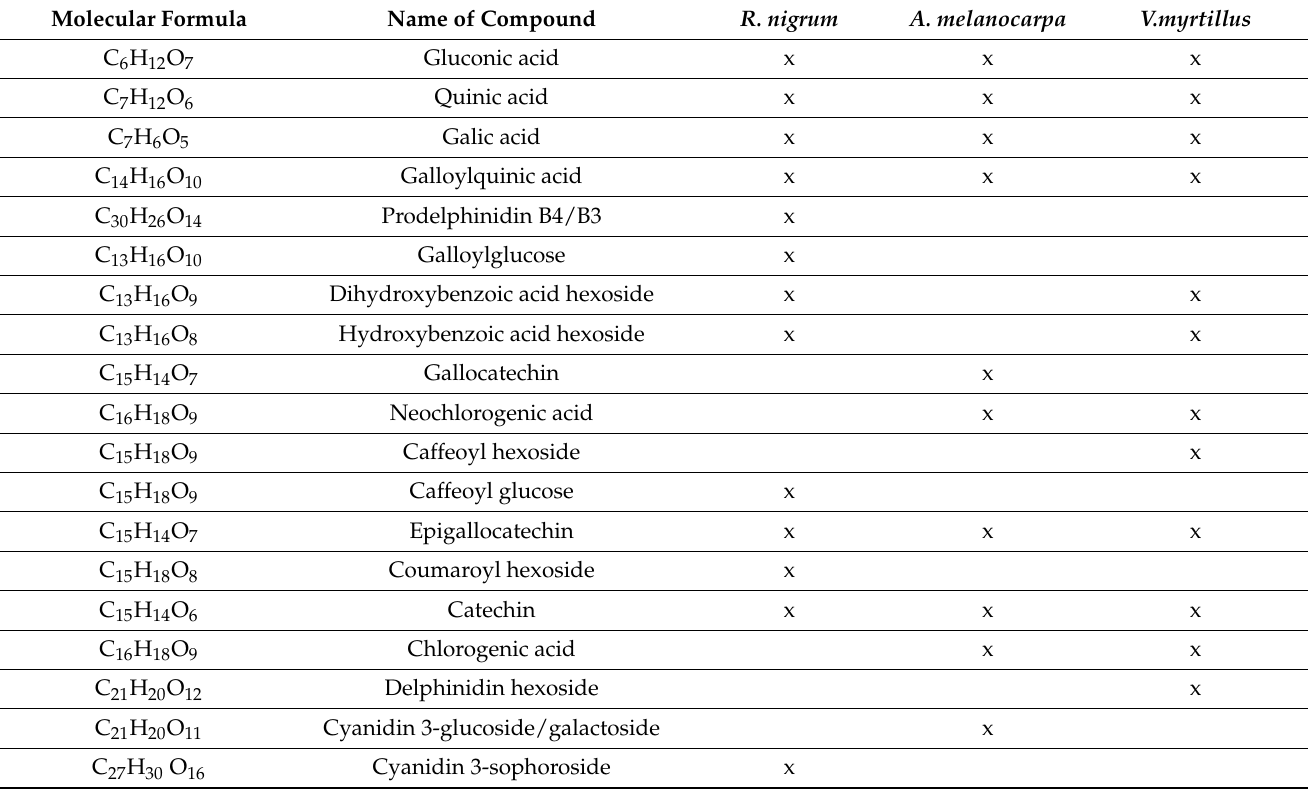
Table 1. Bioactive compounds detected using UHPLC/DAD/ESI–MS in R. nigrum , A. melanocarpa, and V. myrtillus . An x indicates the occurrence of the detected compounds in the tested plant. Molecular Formula Name of